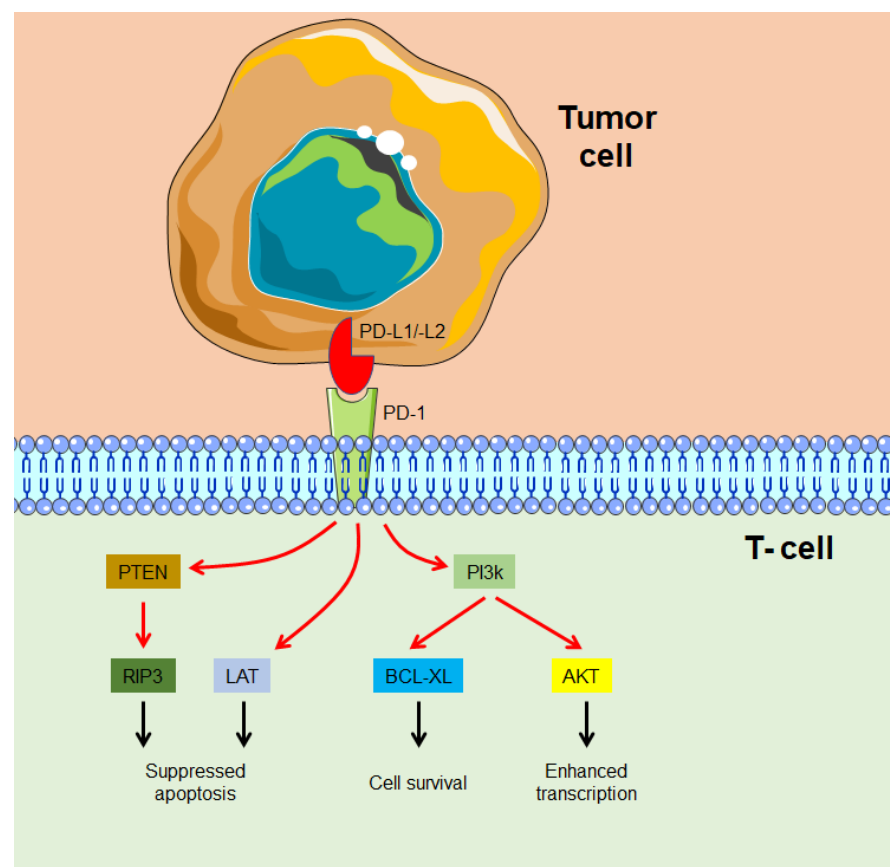
Figure 4. An overview of miRNAs with the ability to target PD-1/PD-L1 in human malignancies.